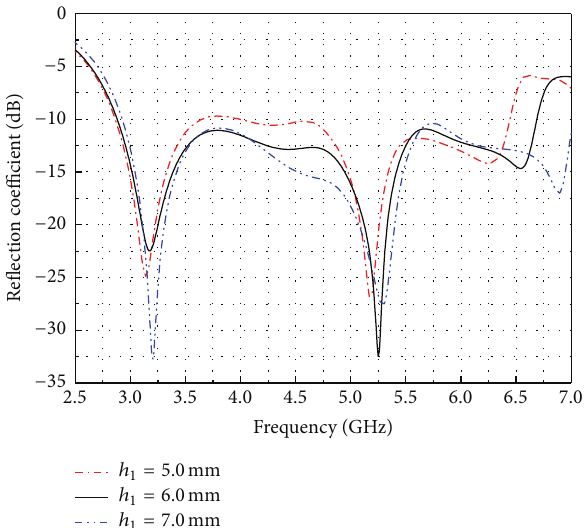
Figure 5: Simulated reflection coefficient with different values of ℎ 1 ( 𝑑 1 = 23.0 mm, 𝑑 2 = 3.0 mm, ℎ 2 = 15.0 mm, ℎ 3 = 10.0 mm, 𝑊 1 = = 2.0 mm, 𝐿 = 4.5 mm, and 𝐿 = 2.5 mm). 13.0 mm, 𝑊 2 1 2